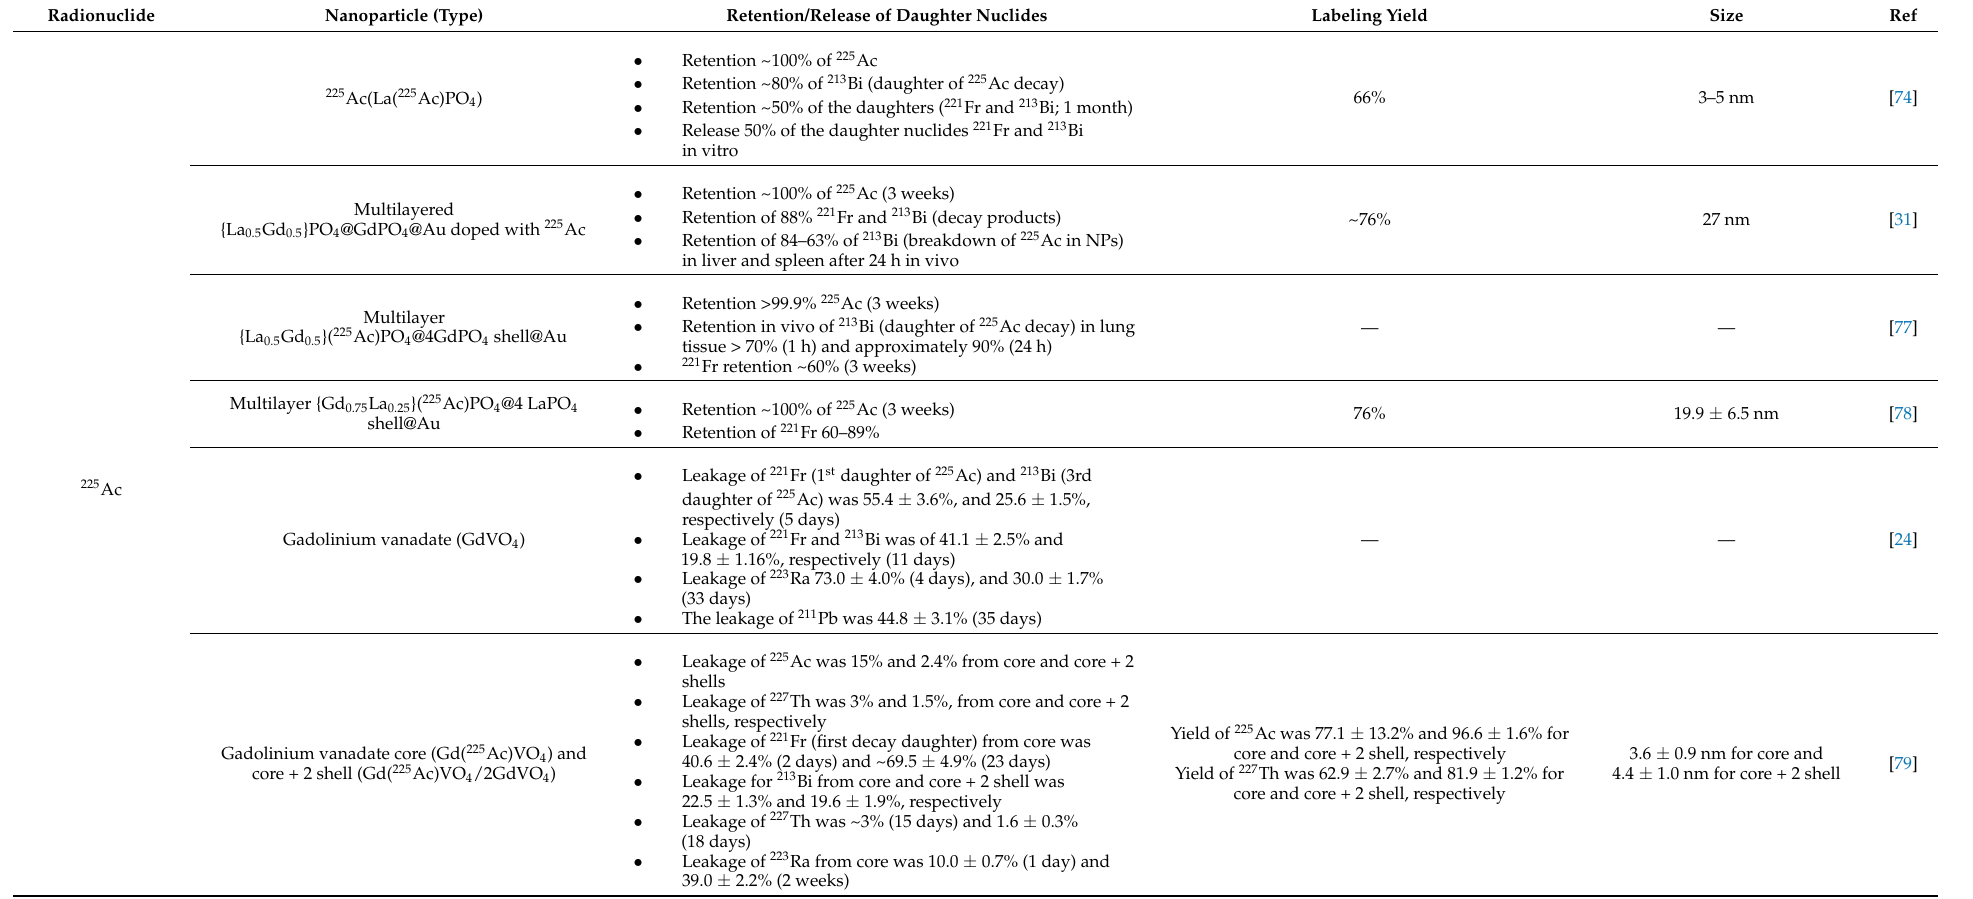
Table 3. Summary of encapsulation of alpha emitters experiments reported in the